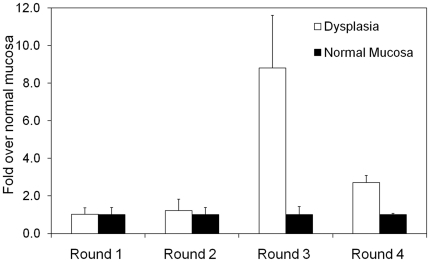
Titer results showing plaque forming units (pfu) for adenomas
normalized to the number of phages bound to normal colonic
mucosa.After two rounds of panning, the recovered phage pool was first cleared
against a homogenized mixture of organs (heart, kidney, liver, normal
colon) and subsequently cleared against normal colon tissue only.
Clearing decreased the number of phage that bound to normal colon tissue
9× or 3× in rounds 3 and 4, respectively. The titer was
performed in triplicate.